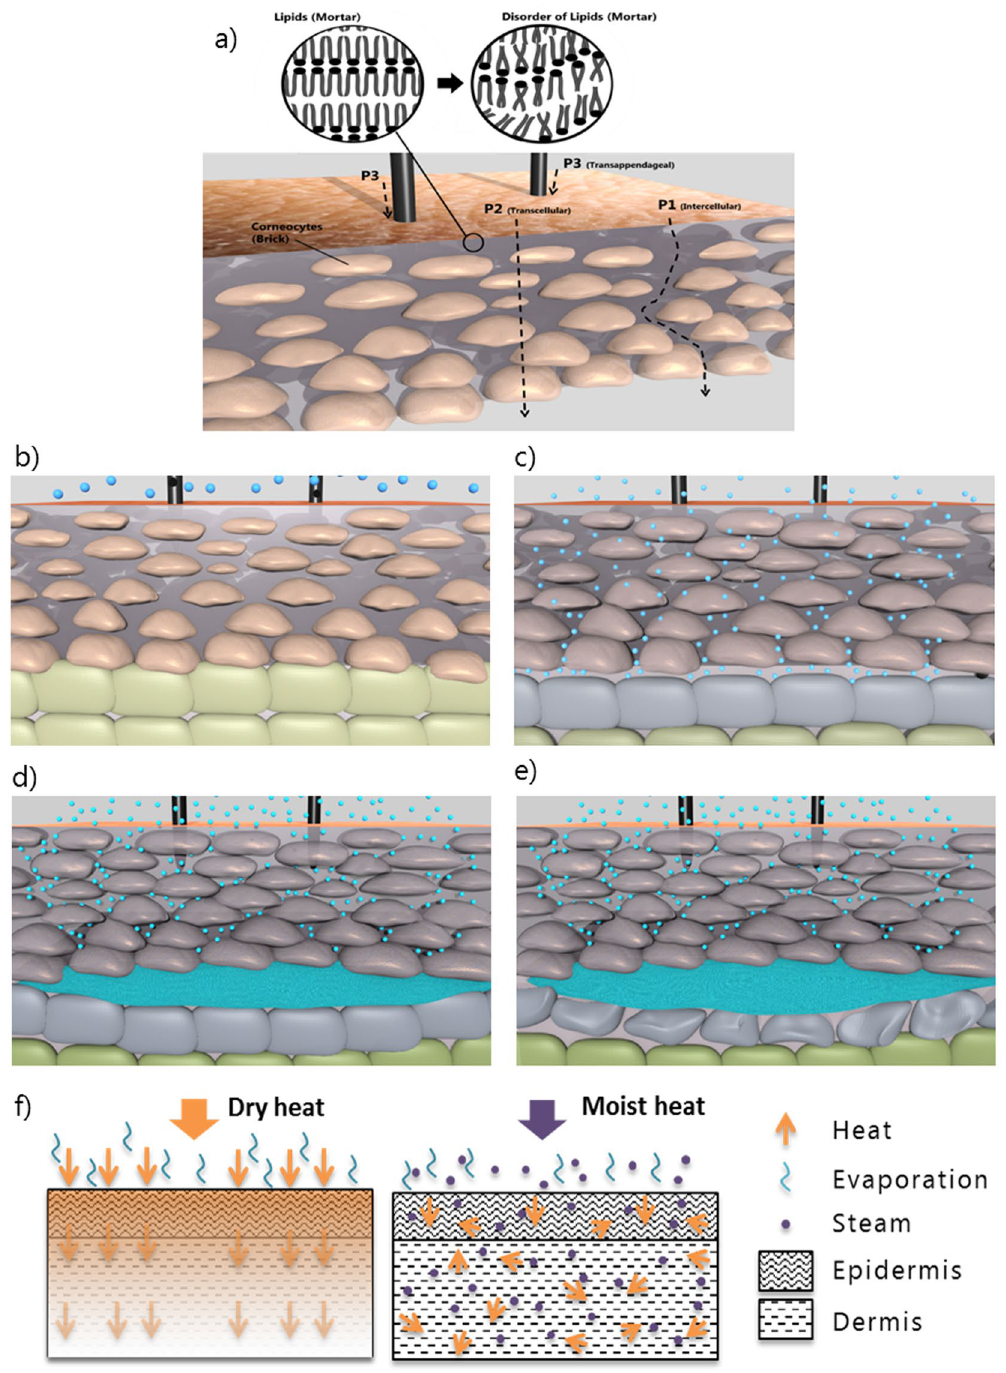
Figure 2. Model of steam diffusion, penetration through the skin and illustration of the second degree burn model without first degree burn. ( a ) Schematic of the different penetration pathways of steam. Detailed illustration of the penetration of steam through the skin: ( b ) Steam in contact with the stratum corneum. ( c ) Penetration of the steam through the 3 pathways and accumulation of steam at the skin barrier (dermis). At this point, corneocytes are starting to swell slowing down the penetration of steam. ( d ) Accumulation of steam and condensation of steam. ( e ) Accumulation of hot water due to condensation of steam and degradation of the first layers of Dermis. ( f ) Schematic of different mechanisms for heat transfer in dry heat condition and in moist heat